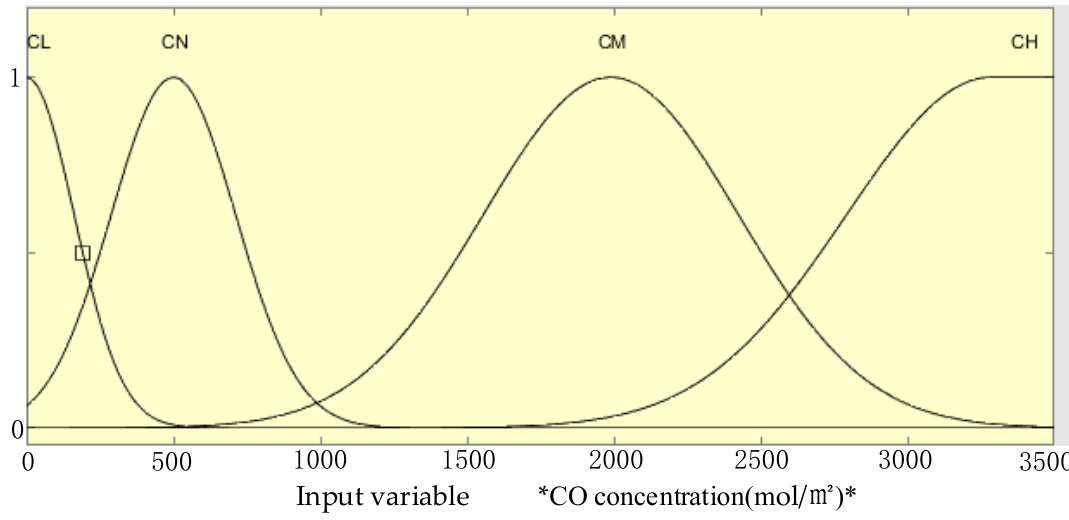
Figure 11. The concentration of CO belongs to the graph of the function.